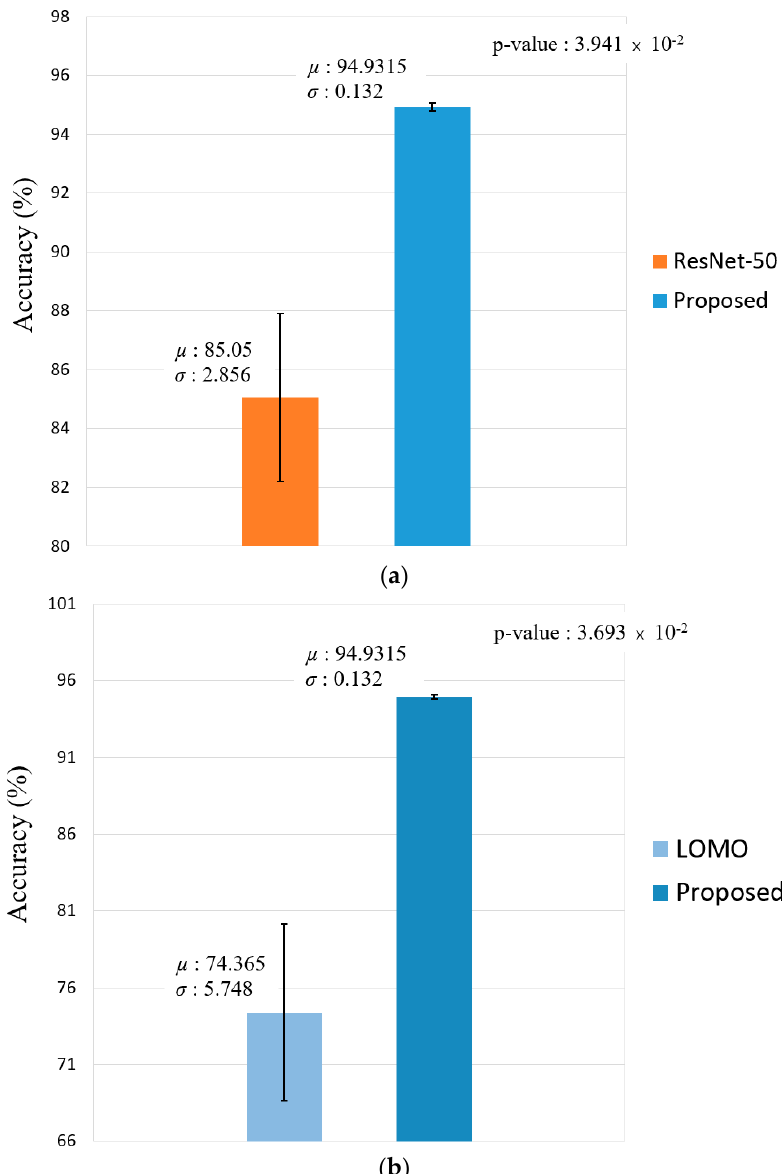
Figure 19. T-test performance of the proposed method and second-best model in terms of average accuracy. ( a ) Comparison of the proposed method and ResNet-50 and ( b ) comparison of the proposed method and local maximal occurrence (LOMO).